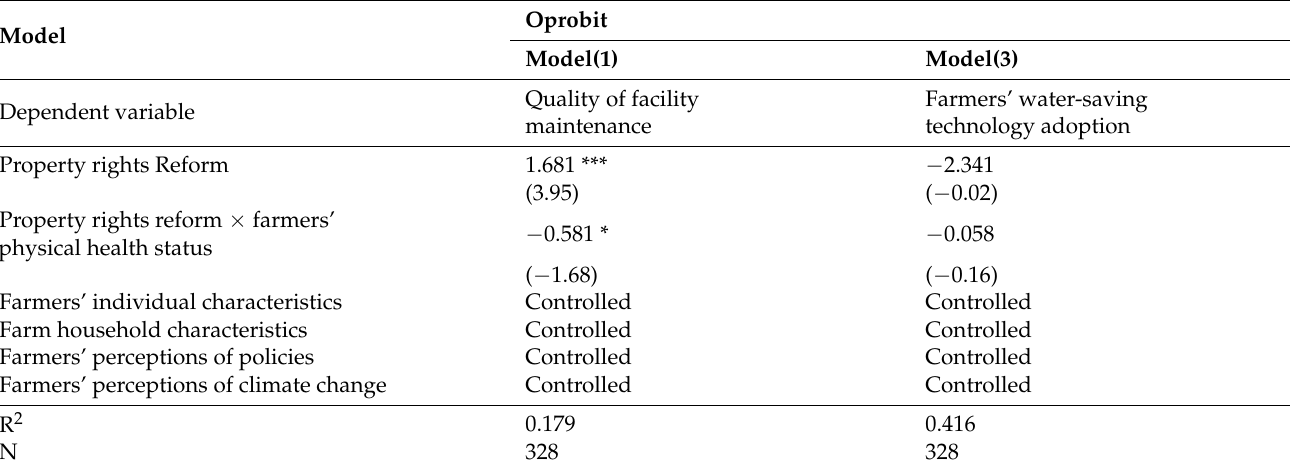
Table 8. Regression results of heterogeneity analysis of farmers’ physical health status.